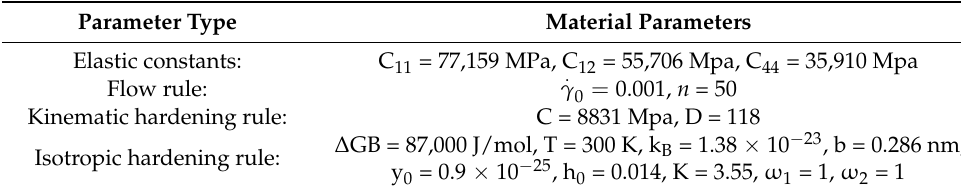
Table 2. The values of material parameters for CPFEM simulation.